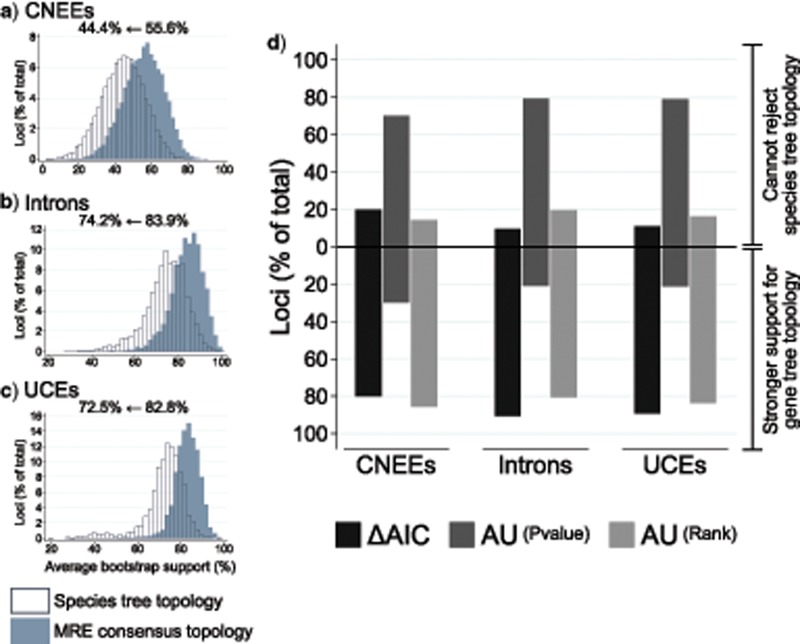
Support for observed topological heterogeneity in estimated gene trees. (a–c) Distributions for the average bootstrap support for all clades recovered in majority rule extended consensus gene trees (“MRE consensus topology”, drawn as solid bars), and the average support when bootstrap replicates for each gene are constrained to the inferred species tree topology (open bars) are shown for CNEEs (a), introns (b), and UCEs (c). Values above each panel indicate the decrease in the grand mean of average support across genes when bootstrap replicates are constrained to the species tree topology. (d) Support that observed gene tree topologies differs from the inferred species tree. Dark gray bars indicate the difference in AIC from values calculated using the MRE consensus topology for each gene, relative to that obtained when the sequence alignment is constrained to the species tree topology. The baseline at 0 corresponds to \documentclass[12pt]{minimal}
\usepackage{amsmath}
\usepackage{wasysym}
\usepackage{amsfonts}
\usepackage{amssymb}
\usepackage{amsbsy}
\usepackage{upgreek}
\usepackage{mathrsfs}
\setlength{\oddsidemargin}{-69pt}
\begin{document}
}{}$CDATA[$CDATA[$\Delta$$\end{document}AIC = -2, thus values beneath this line indicate loci where likelihood values support the gene tree topology substantially better than that of the species tree. Results of AU tests are indicated with medium gray bars showing the proportion of loci that reject (below baseline) and fail to reject (above baseline) the species tree topology at a \documentclass[12pt]{minimal}
\usepackage{amsmath}
\usepackage{wasysym}
\usepackage{amsfonts}
\usepackage{amssymb}
\usepackage{amsbsy}
\usepackage{upgreek}
\usepackage{mathrsfs}
\setlength{\oddsidemargin}{-69pt}
\begin{document}
}{}$CDATA[$CDATA[$P$$\end{document}-value cutoff of 0.05, and light gray bars showing the proportion of loci where the species tree topology occurs among the top 5% of candidate topologies (above baseline), or is within the bottom 95% of tested topologies (below baseline) for AU \documentclass[12pt]{minimal}
\usepackage{amsmath}
\usepackage{wasysym}
\usepackage{amsfonts}
\usepackage{amssymb}
\usepackage{amsbsy}
\usepackage{upgreek}
\usepackage{mathrsfs}
\setlength{\oddsidemargin}{-69pt}
\begin{document}
}{}$CDATA[$CDATA[$P$$\end{document}-values ranked in ascending order. AU tests for the 105 and 1575 candidate tree sets produced similar results and are shown for the 105 candidate set only.